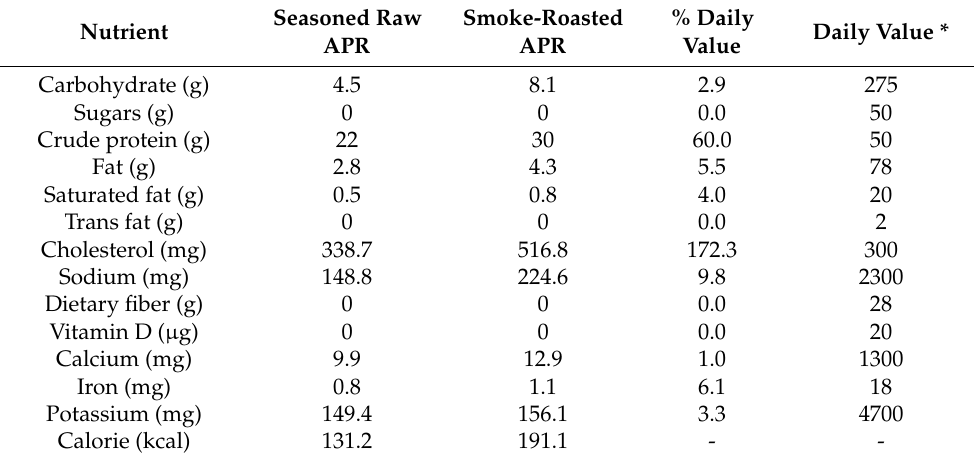
Table 5. Nutritional composition of seasoned raw and smoke-roasted APR (per 100 g).